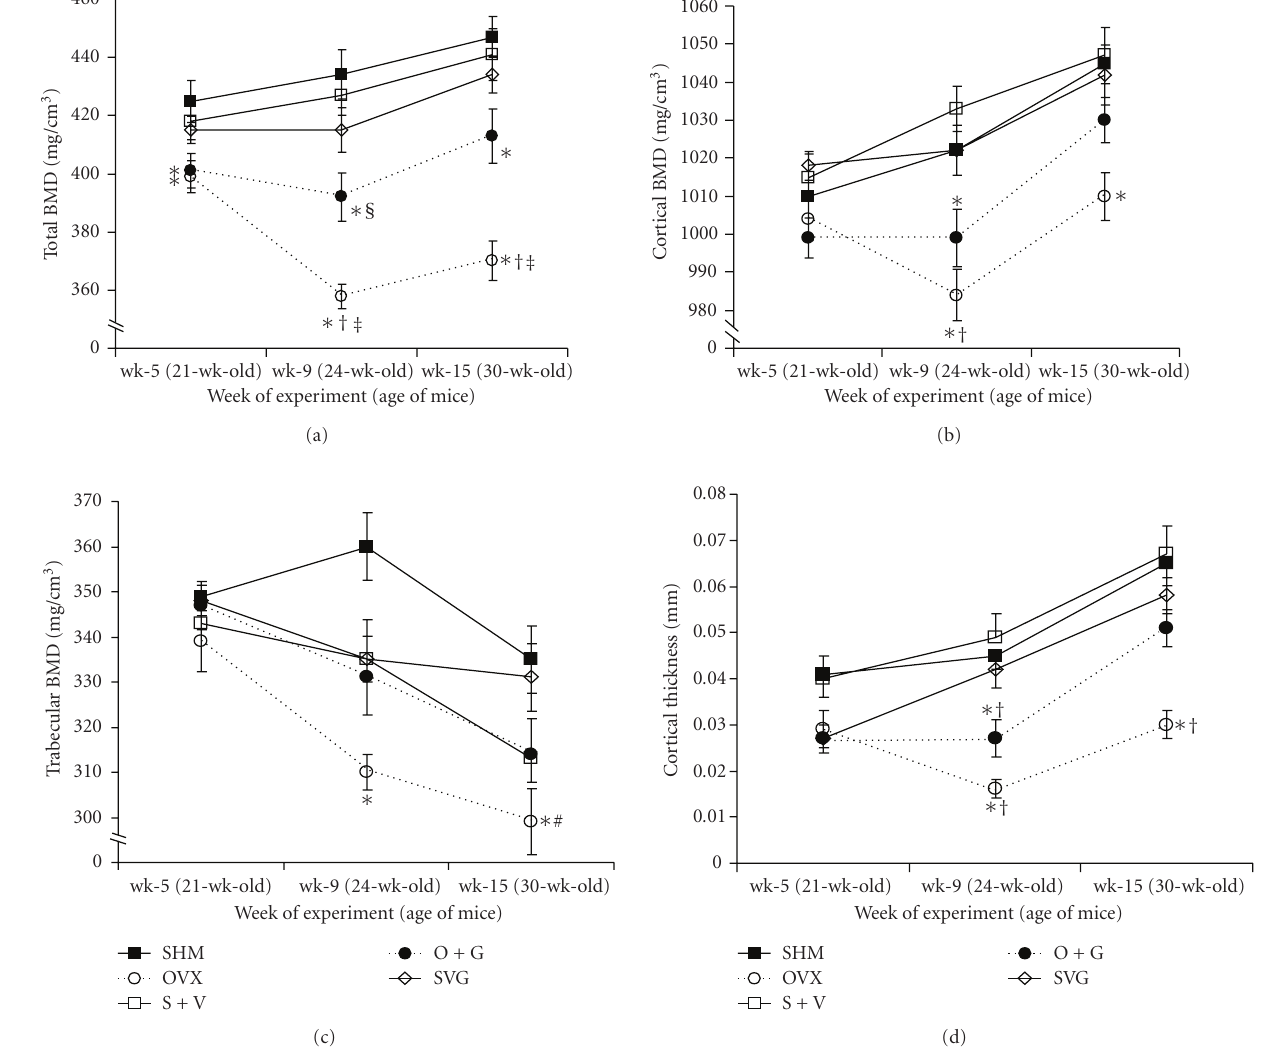
Figure 8: Treatment e ff ects on the bone mineral density and cortical thickness of the proximal tibial metaphysis as assessed longitudinally in vivo via pQCT. Data represent the mean ± SEM values imaged 0.25 mm distal to the tibiofibular junction. Symbols indicate significantly di ff erent means ( P < . 005) as assessed by a one-way ANOVA and subsequent post hoc Tukey tests as follows: ∗ group versus SHM; † group versus VCD-treated mice (S + V and SVG); § group versus SVG; ‡ group vs. O + G; # group versus